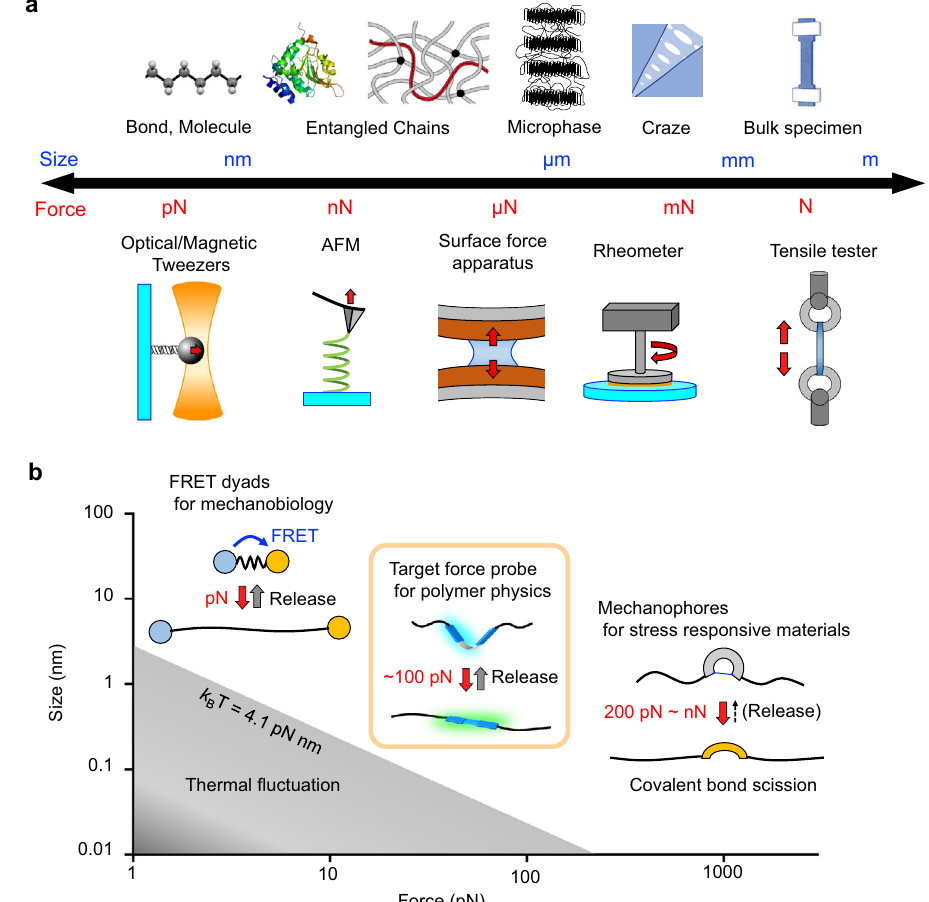
Fig. 1 Material sizes and forces correlated in common measurements. a Hierarchical structures of materials and physical measurement methods of mechanical forces at different scales. b Target force range for the nanoscale study of polymer